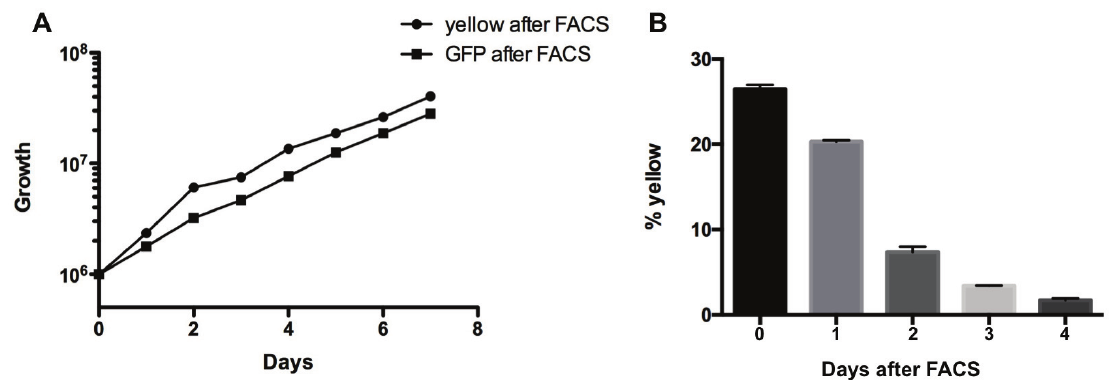
Figure 3. Double-positive cells lose one fluorescent protein over time. A : Growth curve of Δ proc yellow cells after FACS and Δ proc GFP cells after FACS. B : Double-positive Δ proc cells were enriched by FACS and the percentage of yellow cells was measured by flow cytometry at daily intervals.